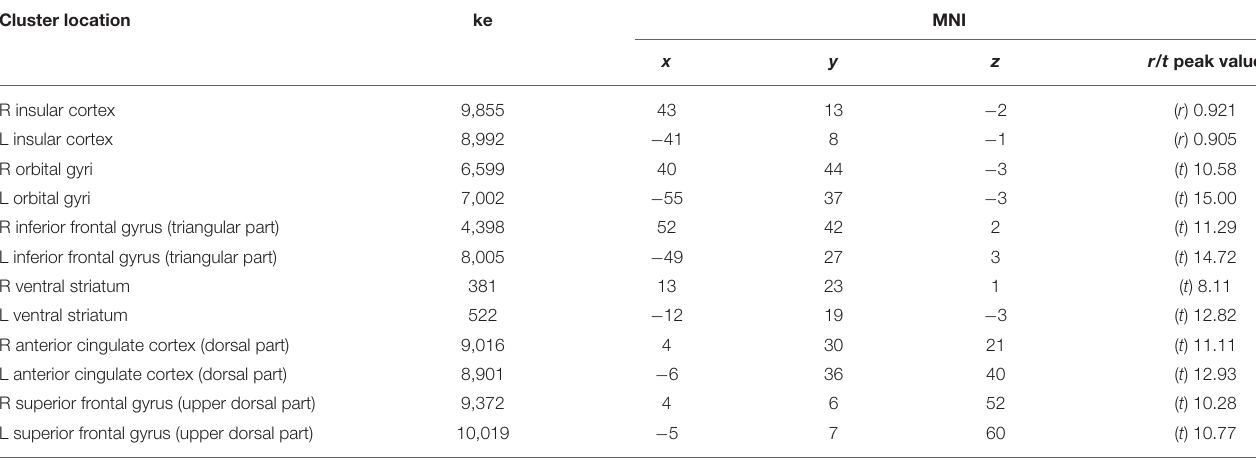
TABLE 4 | Spatial coordinates, extent, and peak values of areas showing significant correlation ( r ) or prevalence ( t ) between GM density loss and hypometabolism in bvFTD patients. Cluster